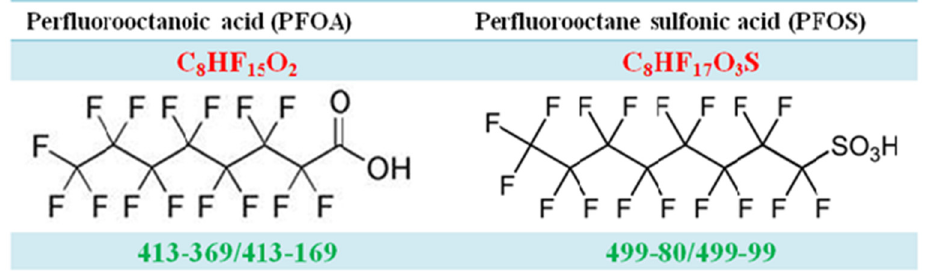
Figure A1. The molecular structure of PFOA and PFOS.